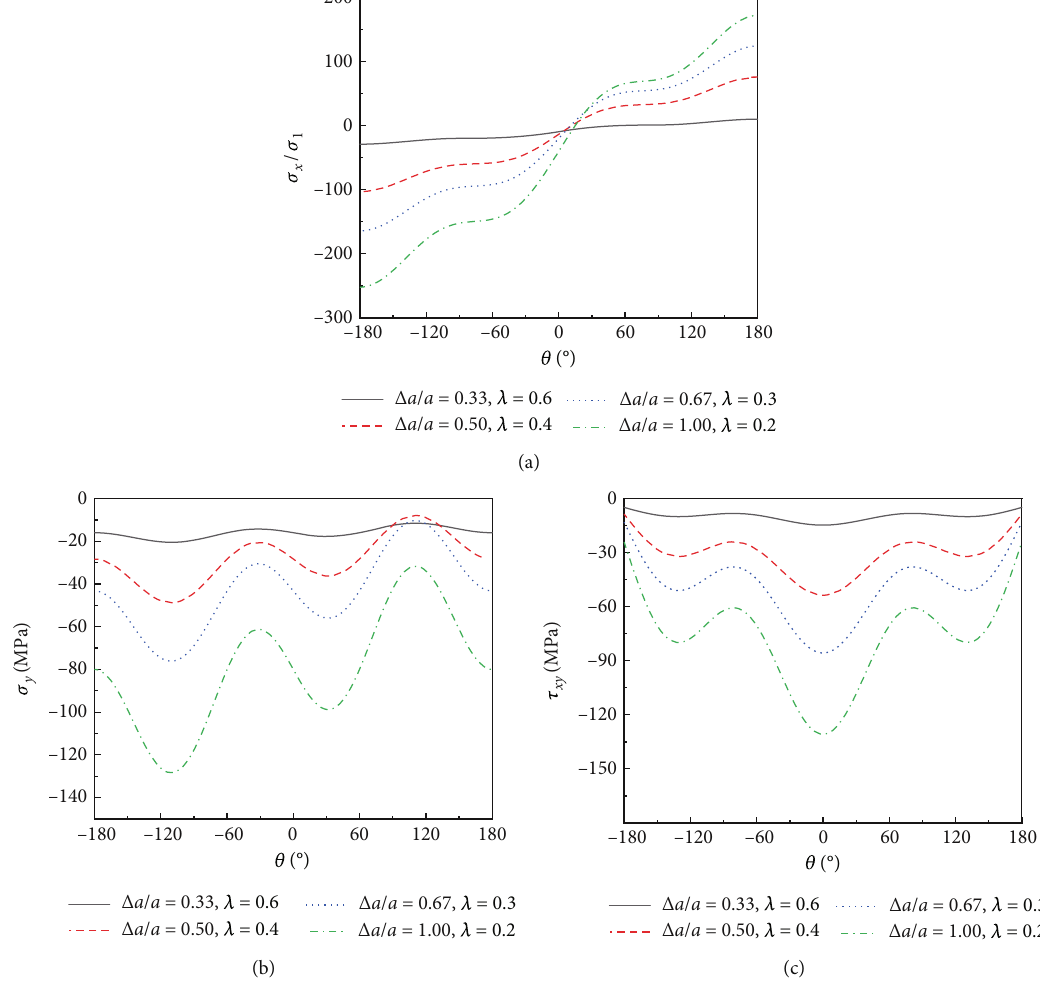
Figure 25: Comparison of stress components on a circle with radius of 0.05mm around the crack tip at di ff erent closures and con fi ning ; (b) σ ; and (c) τ pressure coe ffi cients: (a) σ x y xy